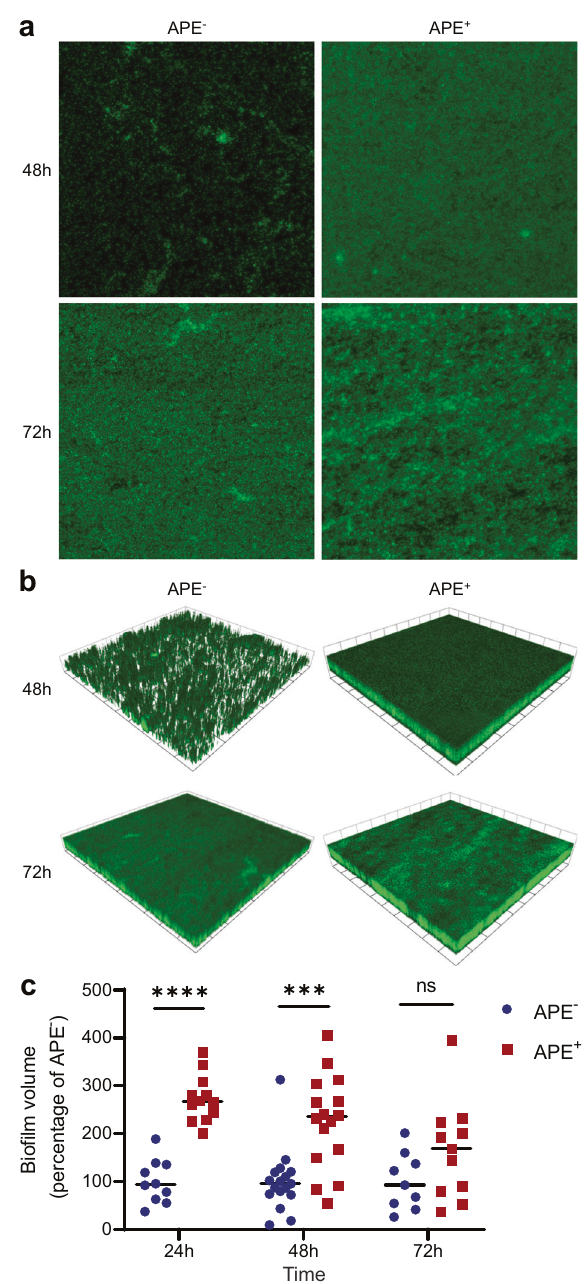
Fig. 7 APE Ec expressing E. coli more rapidly form thicker and denser bio fi lms. a Confocal fl uorescence microscopy images of APE - and APE + E. coli bio fi lms that were grown in non-tissue culture treated multi-well plates for 48 h and 72 h. Samples were fi xed, stained with SYTO 9, and imaged using the 63× objective. b Three-dimensional rendering of the z-stacked images for the APE − and APE + bio fi lms show that APE Ec expression results in the formation of a thicker and denser bio fi lm. 1 scale unit = 57.97 μ m. c The volume of bio fi lm produced by APE + (red) is on average 2.5 times higher than for APE − (blue) after 24 and 48 h of growth. Volocity (Quorum Technologies) was used to measure bio fi lm thickness, render 3D-images and calculate bio fi lm volumes. ( n = 3 repeats; *** p < 0.001, **** p < 0.0001 by unpaired, two-tailed t -test).